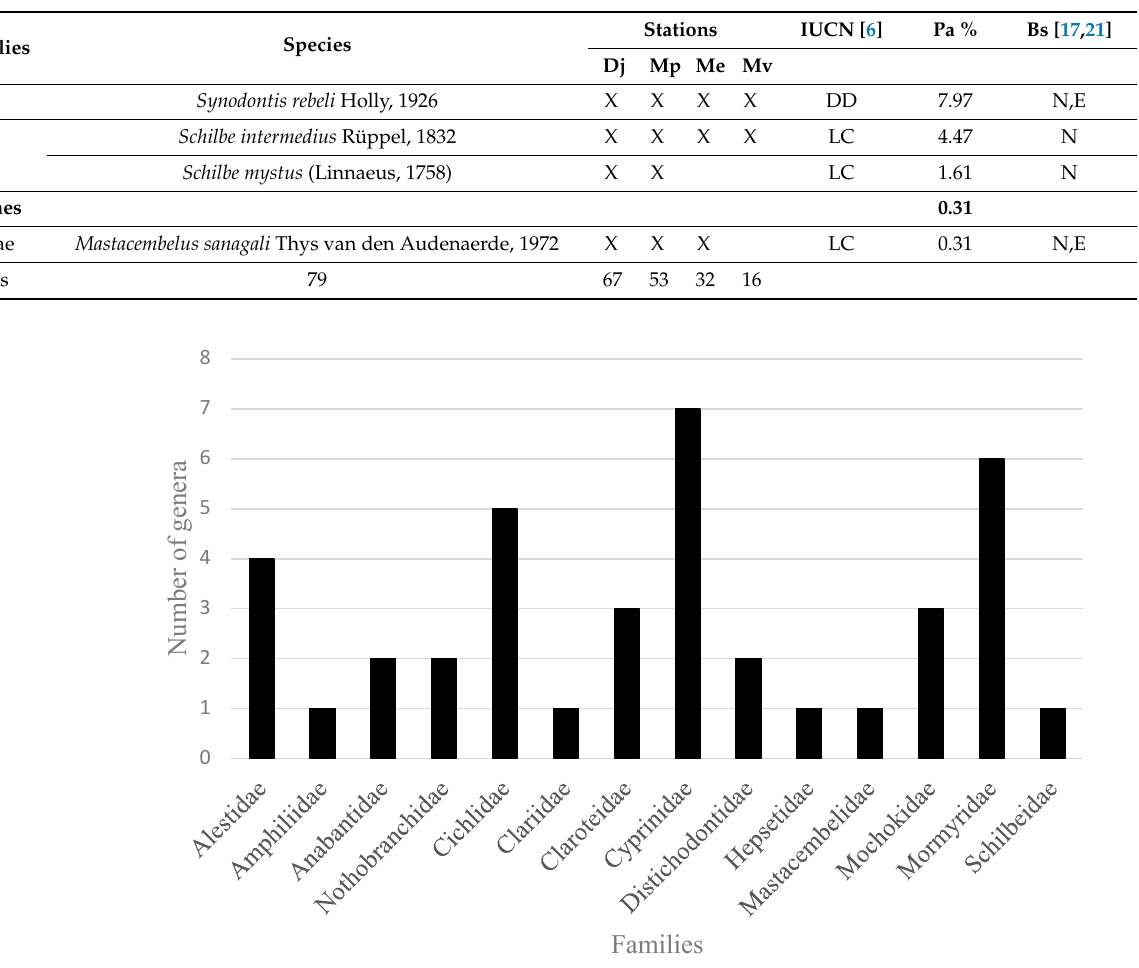
Diversity 2022 , 14 , x FOR PEER REVIEW Figure 3. Number of genera per fish family sampled in the all studied area. Figure 3. Number of genera per fish family sampled in the all studied area.